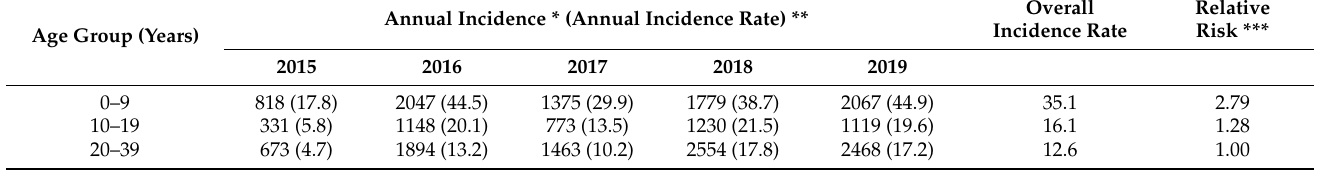
Table 2. Incidence rate of encephalitis by age